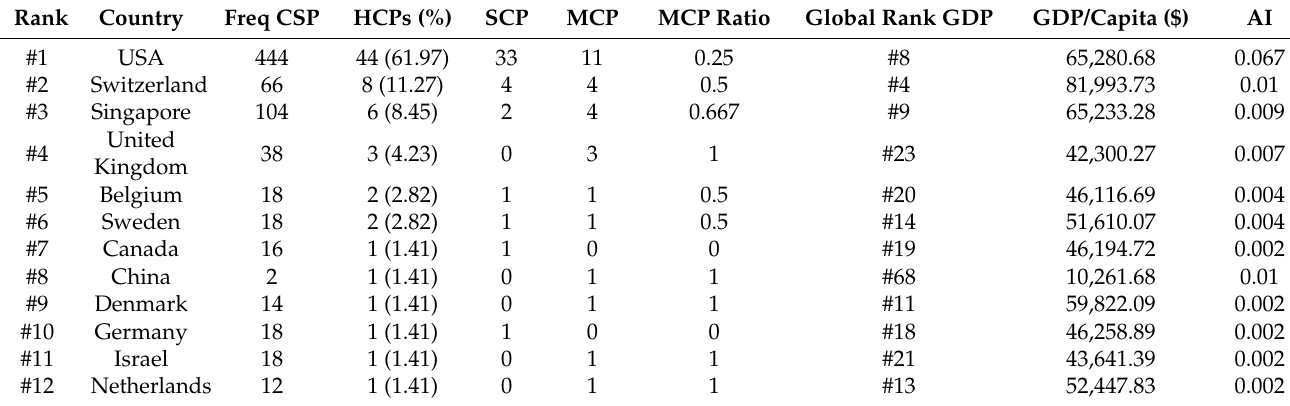
Table 5. Corresponding author’s country and country scientific production in the field of mass cytometry’s highly cited papers